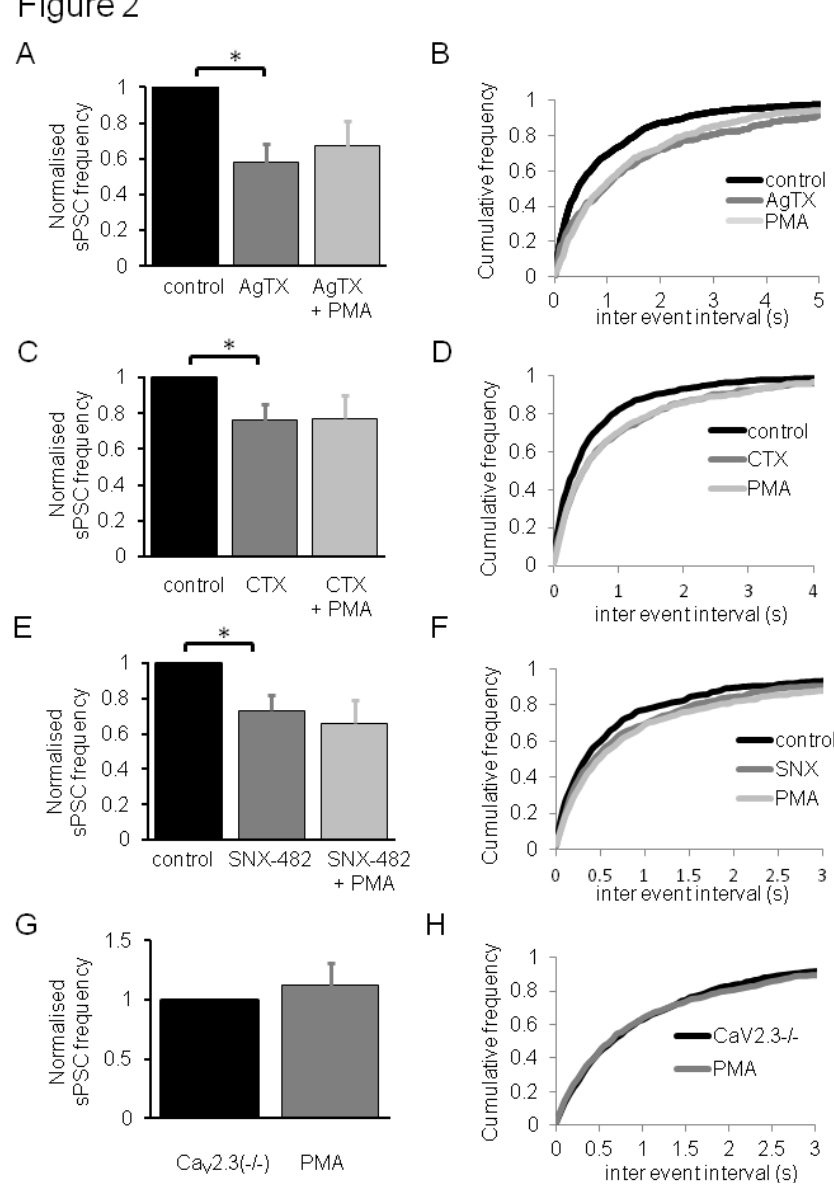
Figure 2. Contribution of Ca 2 VDCC subtypes to PMA effects on nociceptive transmission V in dorsal horn neurones. Bar graphs showing summarised effects of selective VDCC blockers effects on normalised sPSC frequency and PMA (2 µM) actions in the presence of ( A ) 200 nM AgTx (n = 6 ± S.E.M.), ( C ) 1 µM CTX (n = 6 ± S.E.M.) and ( E ) 300 nM SNX-482 (n = 6 ± S.E.M.). ( G ) Bar graph showing summarised effects of PMA (2 M) effects on normalised sPSC frequency in Ca 2.3( − / − ) mice (n = 8 ± S.E.M.). In all cases, V * = p < 0.05 (Mann Whitney U -test). Cumulative frequency plots showing summarised effects of selective VDCC blockers effects on sPSC inter event interval and PMA (2 M) actions in the presence of ( B ) 200 nM AgTx (n = 6 ± S.E.M.), ( D ) 1 M CTX (n = 6 ± S.E.M.) and ( F ) 300 nM SNX-482 (n = 6 ± S.E.M.); each blocker caused a significant decrease in inter event interval, PMA had no further effect in each case using KS -tests. (H) Cumulative frequency plot showing summarised effects of PMA (2 M) effects on normalised sPSC frequency in Ca 2.3( − / − ) mice (n = 8 ± S.E.M.); data sets not significantly different using KS V